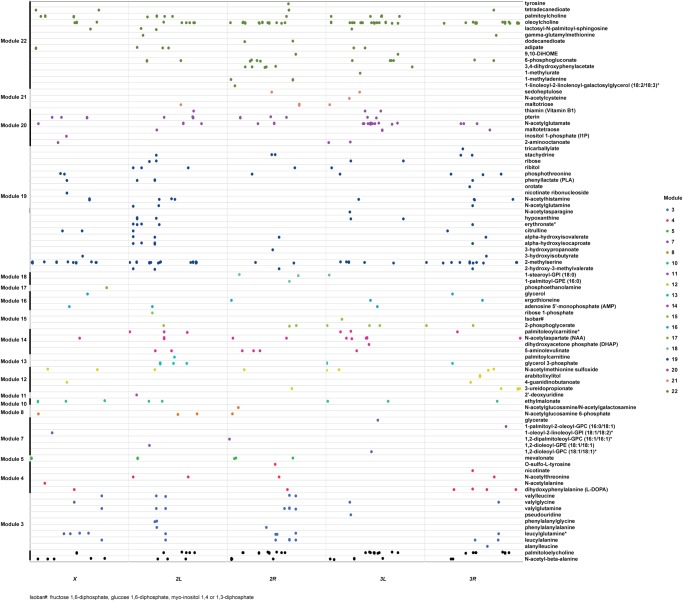
Polymorphic markers associated with variation in metabolites at a Bonferroni-corrected threshold of significance in females. Metabolites and polymorphic markers are ordered according to the modules identified in Figure 2 and color-coded. Black symbols represent polymorphic markers that are associated with metabolites that are not contained in modules.